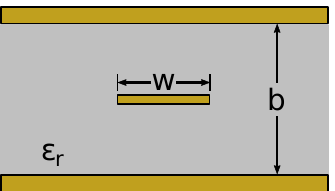
Figure 8. Cross-section of a stripline transmission